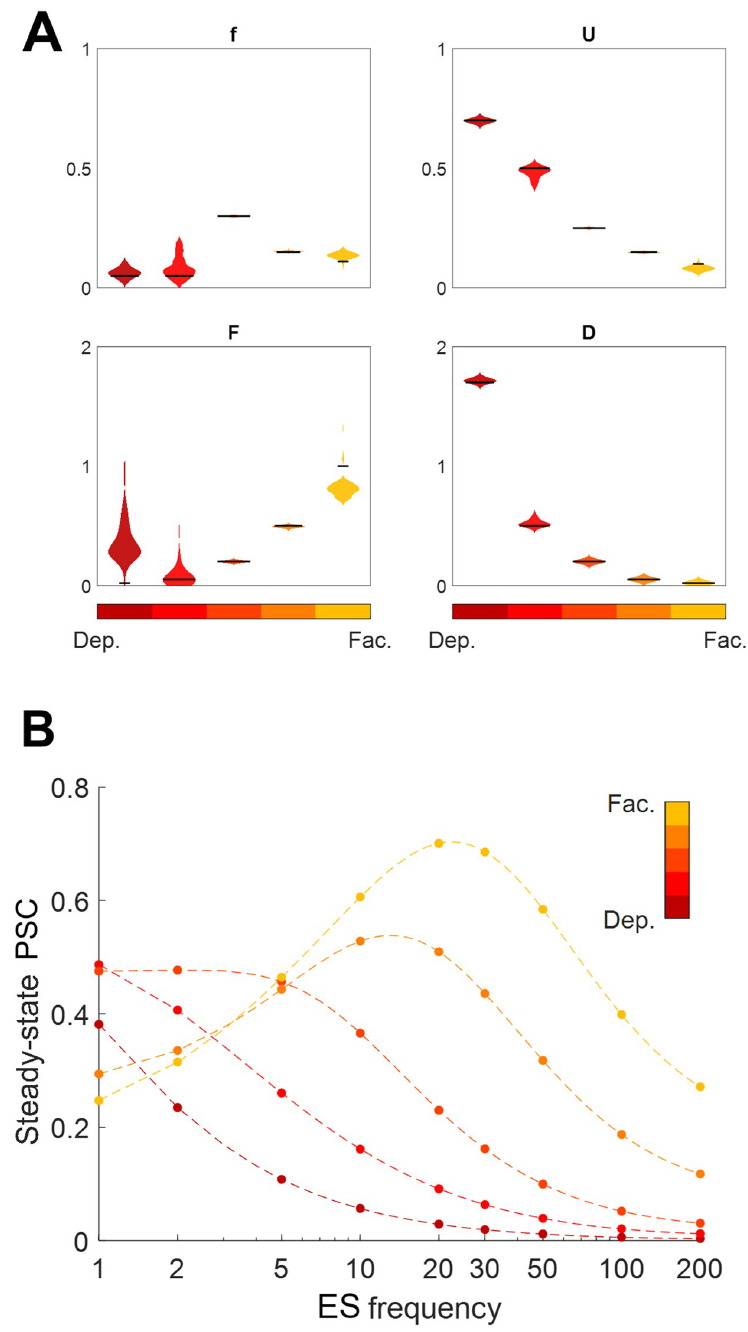
Fig 2. Parameter estimation of TM model using steady-state responses of postsynaptic currents. ( A) Distribution of estimated parameters of the TM model for 5 different types of synaptic plasticity [15]. The violin plots and black bars show the distribution of estimated parameters and their true values, respectively. ( B) Steady-state PSC in response to stimulation of different frequencies for true (dots) and a randomly selected set of the estimated parameters (dashed